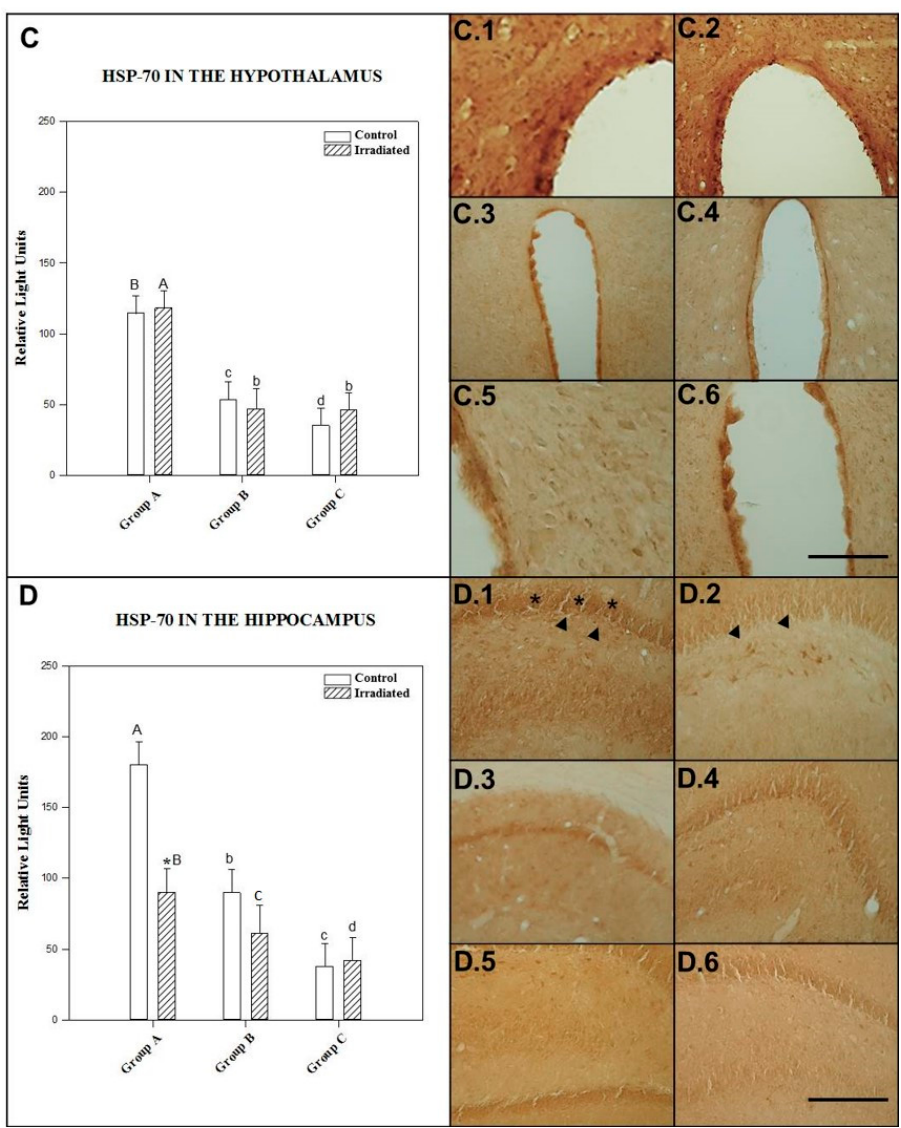
Figure 2. The histograms represent HSP-70 levels detected by ELISA in the hypothalamus ( C ) and the hippocampus ( D ) 1.5 h (Group A) and 24 h (Group B) after acute exposure and 1.5 h after final repeated exposure (Group C) to a 2.45 GHz signal at 0 and 3 W. Each bar represents mean ± SEM ( n = 24 samples/per group). Asterisks (*) indicate statistically significant differences ( p < 0.05) between the irradiated and control for each group. a, b, c, d indicate statistically significant differences ( p < 0.05) between irradiated or nonirradiated animals comparing between the different groups A, B, C, which were determined using two-way ANOVA followed by the Holm-Sidak test for multiple comparisons. The photographs show the HSP-70 immunomarkers for groups A, B and C in the hypothalamus, control (C.1, C.3 and C.5) and irradiated animals (C.2, C.4 and C.6); in the hippocampus, control (D.1, D.3 and D.5) and irradiated animals (D.2, D.4 and D.6) ( n = 15 samples/per group). In the photos it is indicate with the arrowhead and asterisk that means increase on regional cytolocalization. Scale bar = 60 µm.